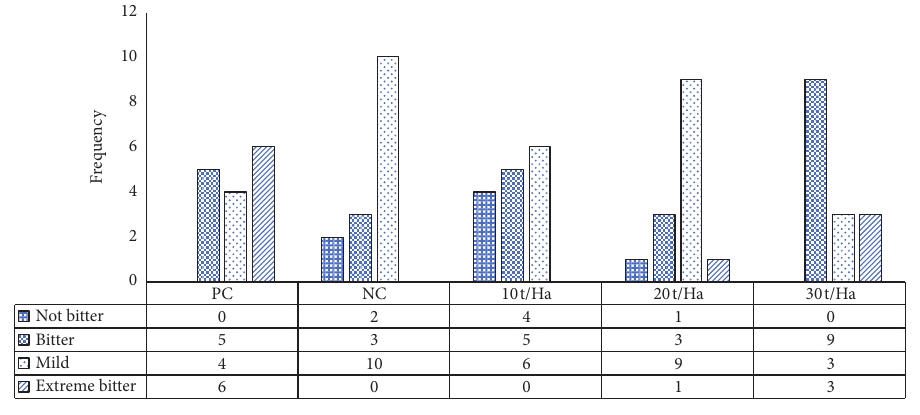
Figure 4: Sensory evaluation. ∗ Total score per treatment � 15. PC � positive control. NC � negative control. t/ha � spent mushroom rate per